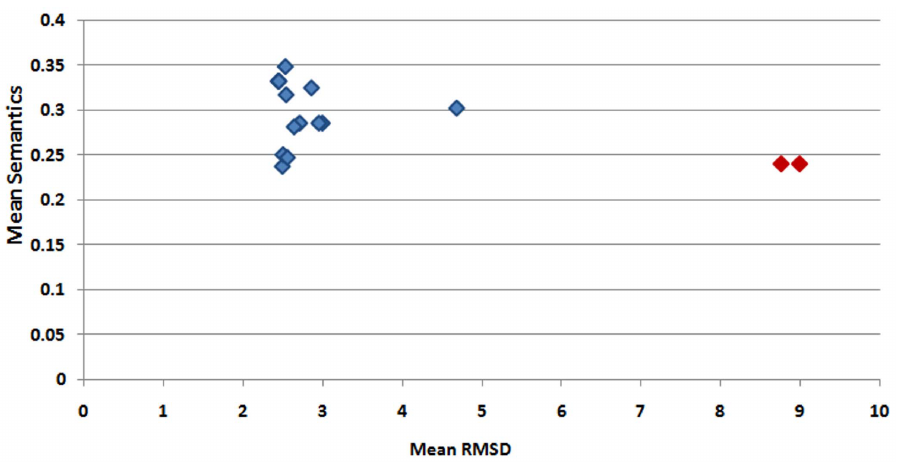
Figure 11. Comparison of mean structural deviation (rmsd) of the members (shown in X-axis) and mean GO semantics scores for ADC-like superfamily (shown in Y-axis). Higher RMSD reflects higher structural deviation and lower mean GO semantics shows lower functional correspondence of a member with other members of that superfamily. The points corresponding to outliers are shown in red colour and non-outlier members of a superfamily are marked with blue